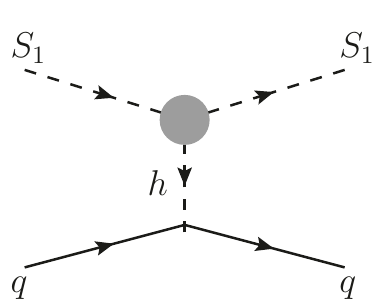
Figure 6 . Diagrams contributing to the direct detection of S 1 . The gray circle represents the sum of the (tree-level and 1-loop) vertices of figure